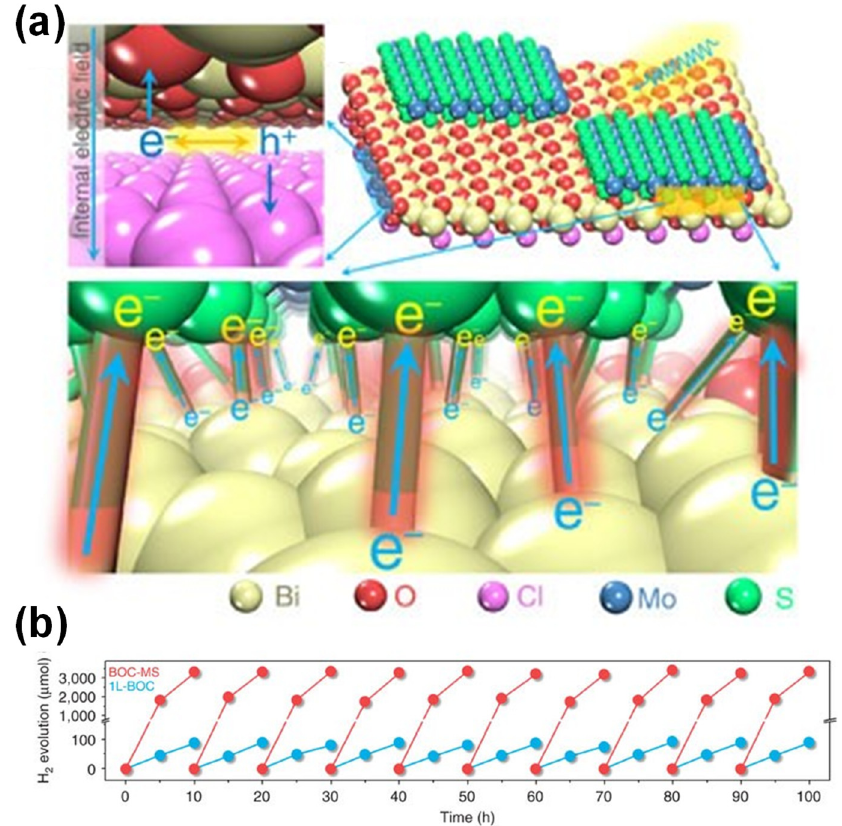
Figure 8. ( a ) Schematic illustration of the charge flow processes within monolayer MoS 2 and mono- layer Bi 12 O 17 Cl 2 , and the interfacial electron transfer along the Bi-S bonds of MoS 2 /Bi 12 O 17 Cl 2 bilayer junction photocatalyst; ( b ) Cycling tests of photocatalytic H 2 evolution over as-prepared MoS 2 /Bi 12 O 17 Cl 2 catalysts [55]. Copyright 2016, Nature Publishing